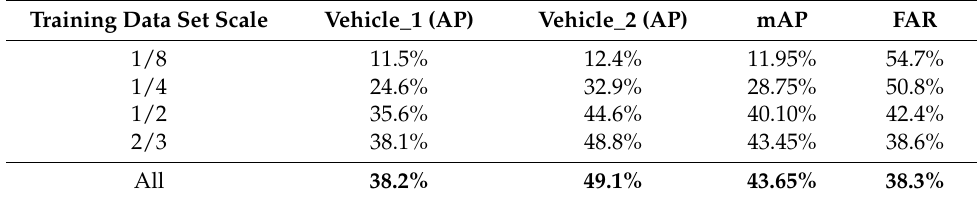
Table 2. Comparisons of different data set scale. The bold value indicates the best performance of each